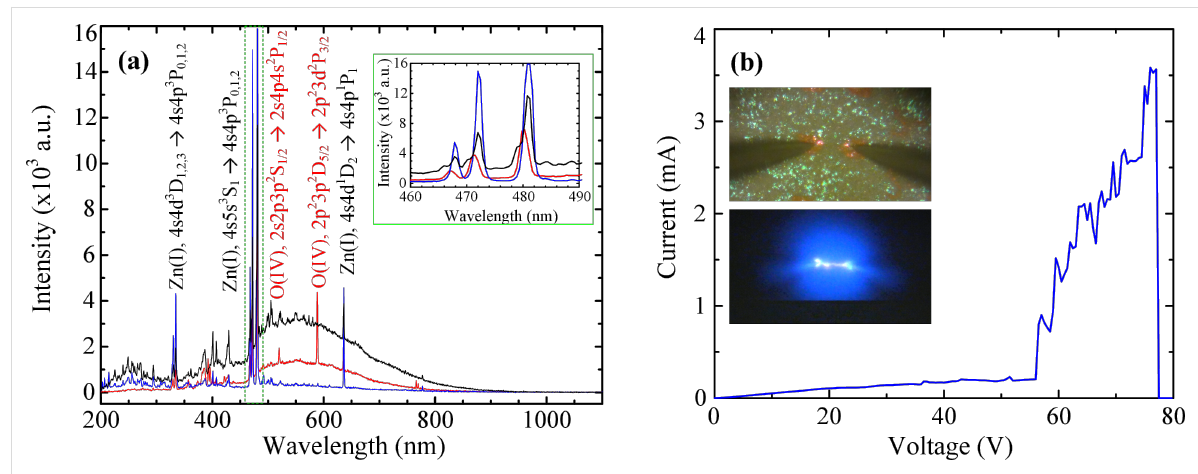
Figure 5: (a) Optical emission spectra obtained from DC voltage sweeping of 0–80 V (blue), AC excitation with an amplitude of 40 V at 1 kHz (red), and single pulse voltage with an amplitude of 35 V and a duration of 10 μ s (black). The corresponding atomic electron transitions in the excited species are indicated adjacent to the spectral lines. The inset shows the characteristic peaks (triplet) for neutral Zn atoms. (b) Example of a DC, I – V characteristic from 0–80 V in steps of 1 V through the ZnO nanorods. The entire DC sweep was carried out in ≈ 10–15 s. The insets show the optical image of the probe arrangement before the test (top) and a frame from the high-resolution video of the light emission (bottom).